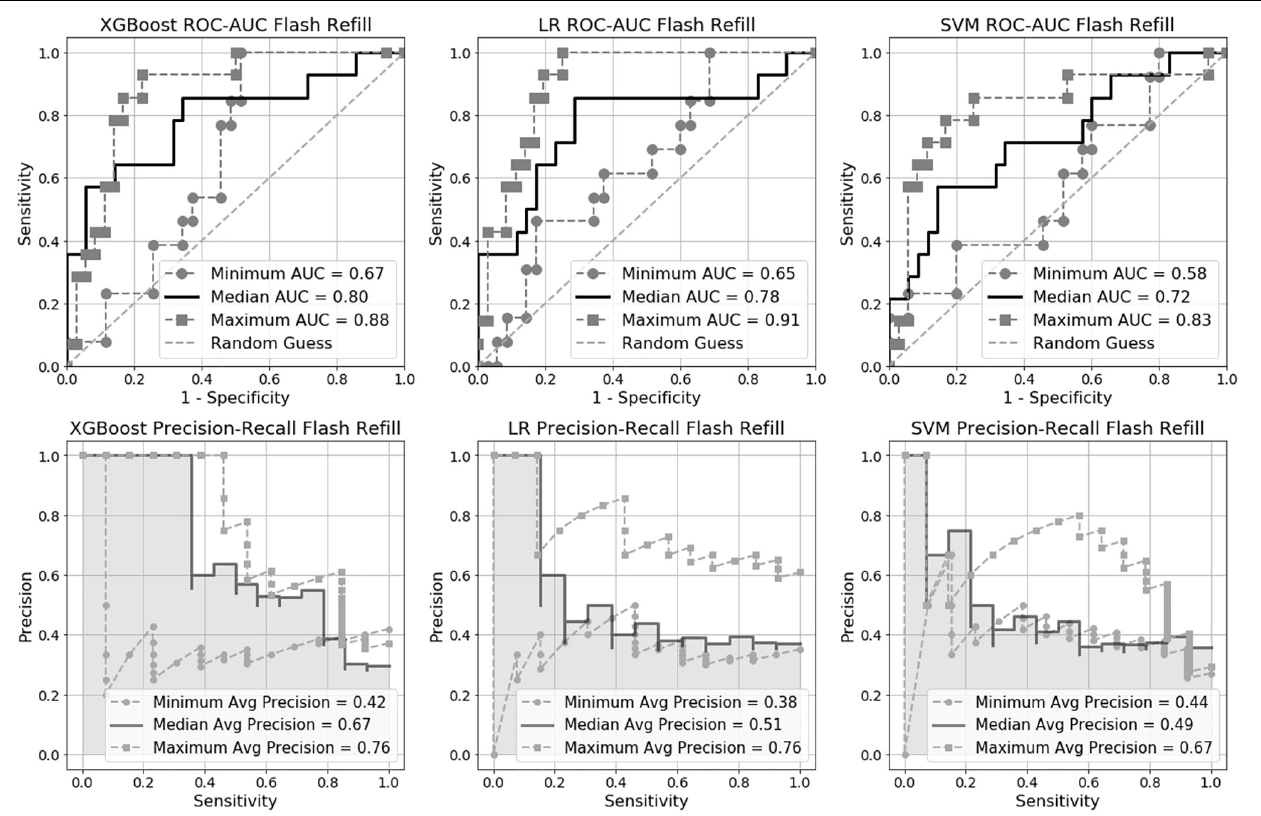
FIGURE 2 | Receiver Operating Characteristic Area Under the Curve (ROC-AUC) and precision-recall for flash capillary refill time (CRT) models.